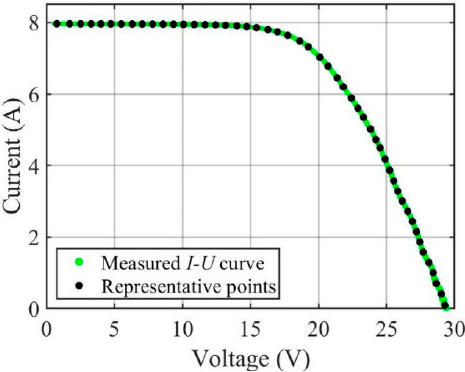
Figure 1. Measured I – U curve jointly with 50 representative points.